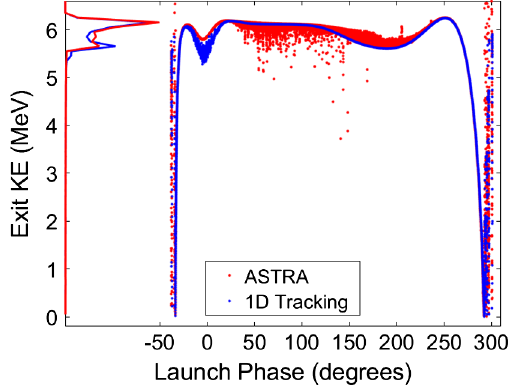
FIG. 11. Comparison of 1D tracking code and ASTRA tracking results at the exit of the linac. The solid lines are KE spectrum and the dots are KE as a function of launch